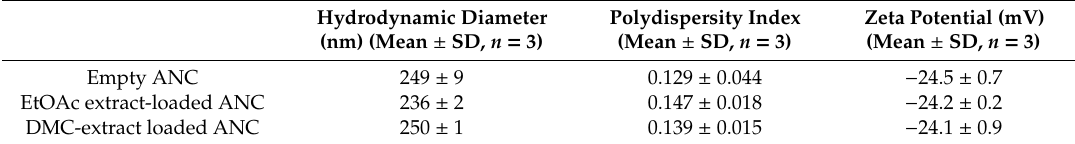
Table 3. Physicochemical characteristics of extract-loaded alginate-based